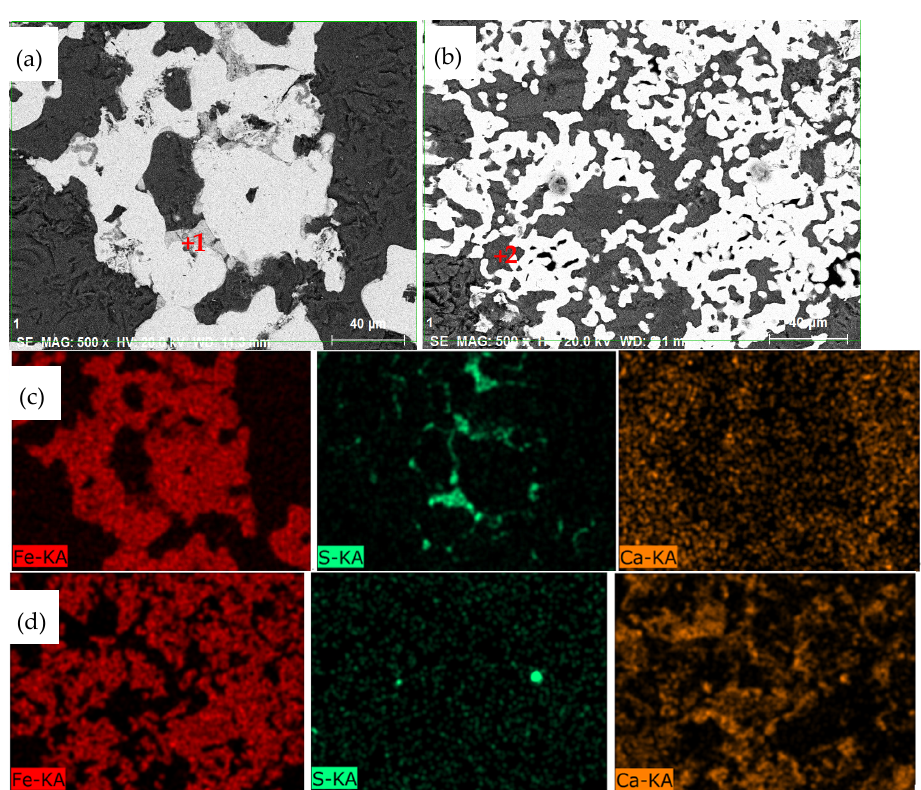
Figure 8. SEM images of roasted products under different CaO dosage. ( a ) 0 wt% CaO; ( b ) 5 wt% CaO; ( c ) 10 wt% CaO; ( d ) 15 wt% CaO.